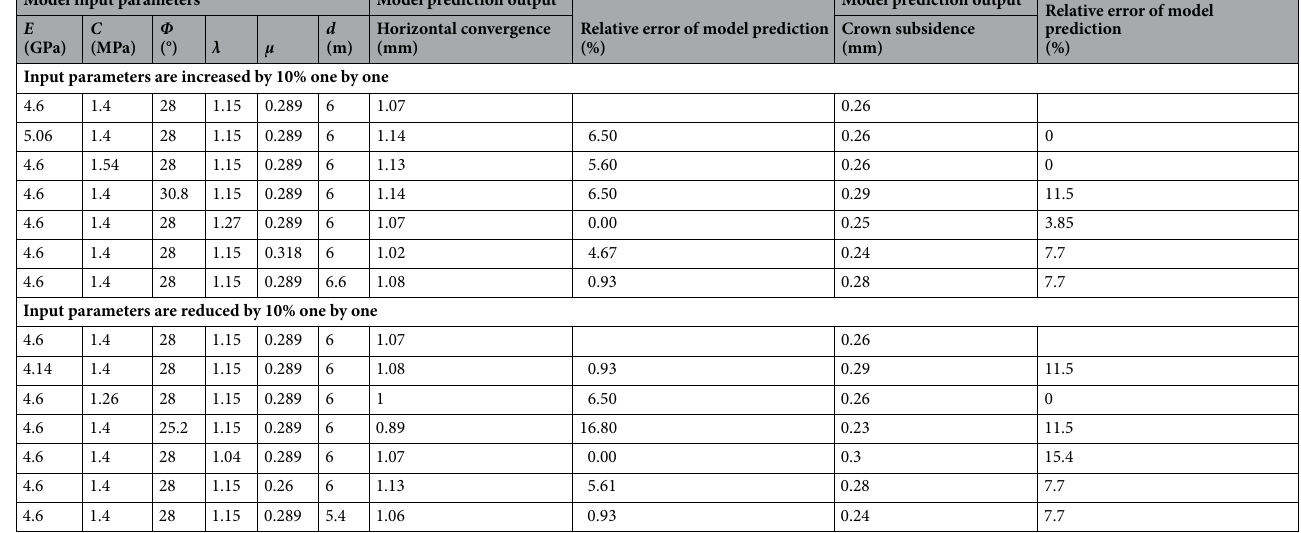
Table 11. Model robustness detection and analysis table.